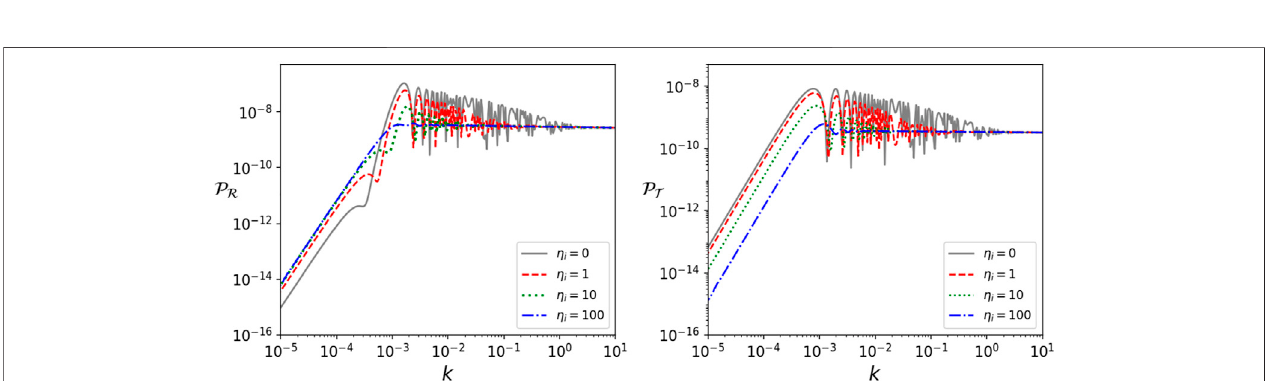
FIGURE 3 | Power spectra of the comoving curvature perturbation P R and tensor perturbation P T corresponding to the SLEs obtained with the window function ( Eq. 15 ) covering the expanding branch until the onset of in fl ation with starting points: η 0 (cid:1) 0 (solid gray line), η 0 (cid:1) 1 (dashed red line), η 0 (cid:1) 10 (dotted green line) and η 0 (cid:1) 100(dotted-dashed blueline). Thescaleof k isinPlanckunits. Allcomputationswereperformedforaquadraticpotential V ( ϕ ) (cid:1) m 2 ϕ 2 /2,with m (cid:1) 1.2 × 10 – 6 and withthe value of the scalar fi eld at the bounce fi xed to ϕ B (cid:1) 1.225 (toy value).